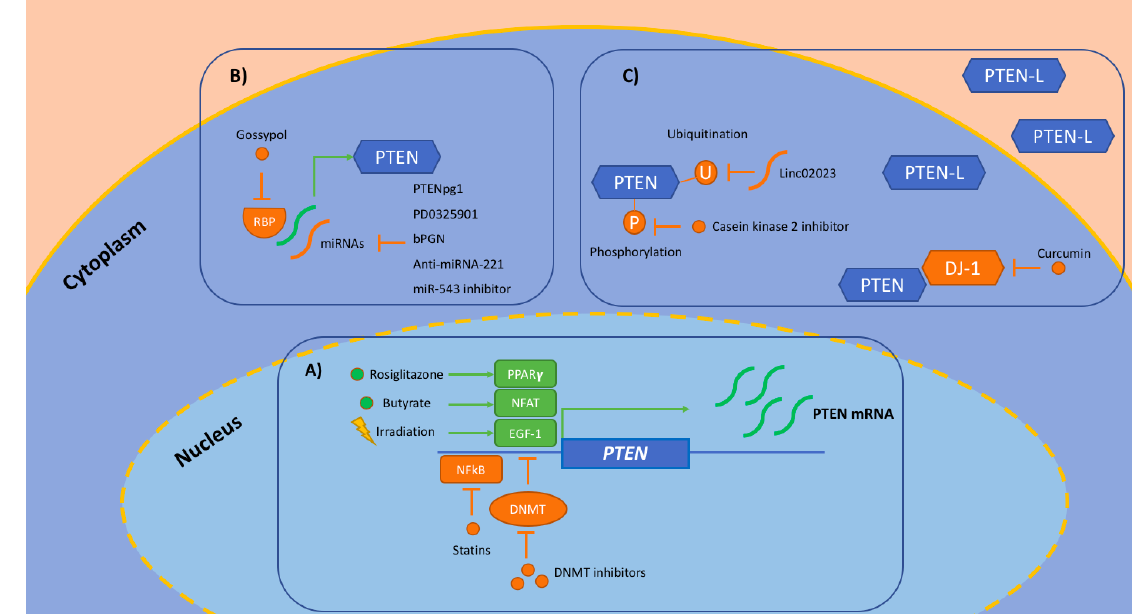
Figure 2. PTEN as a target. Strategies aiming at restoring PTEN onco-suppressor functions that have been hypothesized and are currently under evaluation in early phases of research in preclinical settings. ( A ) Transcriptional level: increase of PTEN transcription achieved by removing epigenetic silencing via DNMT inhibitors, or by modifying (increasing or reducing) exposure to transcription factors. ( B ) Post-transcriptional level: enhanced PTEN translation via the modulation of regulatory miRNAs and RBP. ( C ) Post-translational level: modulation of PTEN modifications, which regulate PTEN activity, conformation and subcellular compartmentalization, and protein – protein interactions. EGR-1: early growth response protein 1. DNMT: DNA methyltransferase. miRNA: microRNA. NFAT: nuclear factor of activated T-cells. NF- κB : nuclear factor kappa-light-chain-enhancer of activated B cells. PPARγ : peroxisome proliferator-activated receptor gamma. PTEN: Phosphatase and tensin homolog. RBP: RNA-binding protein.